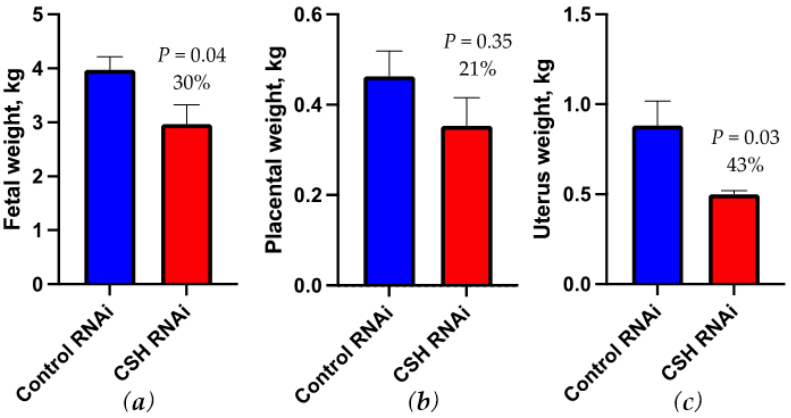
CON RNAi CSH RNAi % Change p -Value